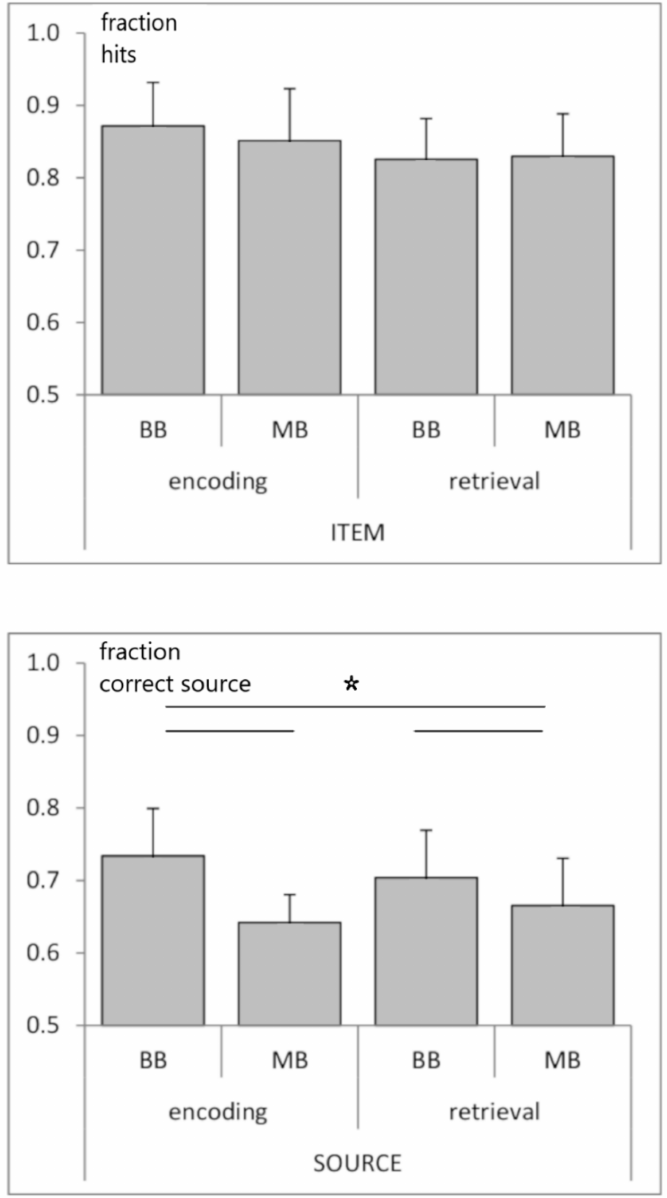
Figure 2. Modulation of memory performance by beat stimulation: fraction of hits (top, item mem- ory) and fraction of correct source responses (bottom, source memory) for binaural (BB) vs. monaural (MB) beat stimulation during encoding and retrieval. Horizontal lines and asterisks indicate a significant ANOVA main effect of beat condition (but not of task phase) for source memory ( p <